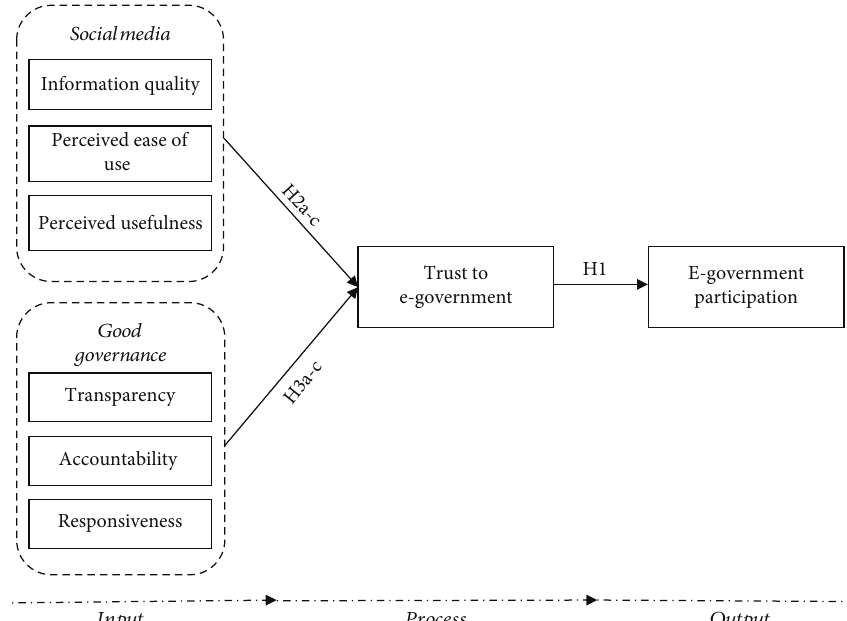
Figure 1: Proposed conceptual model predicting e-government